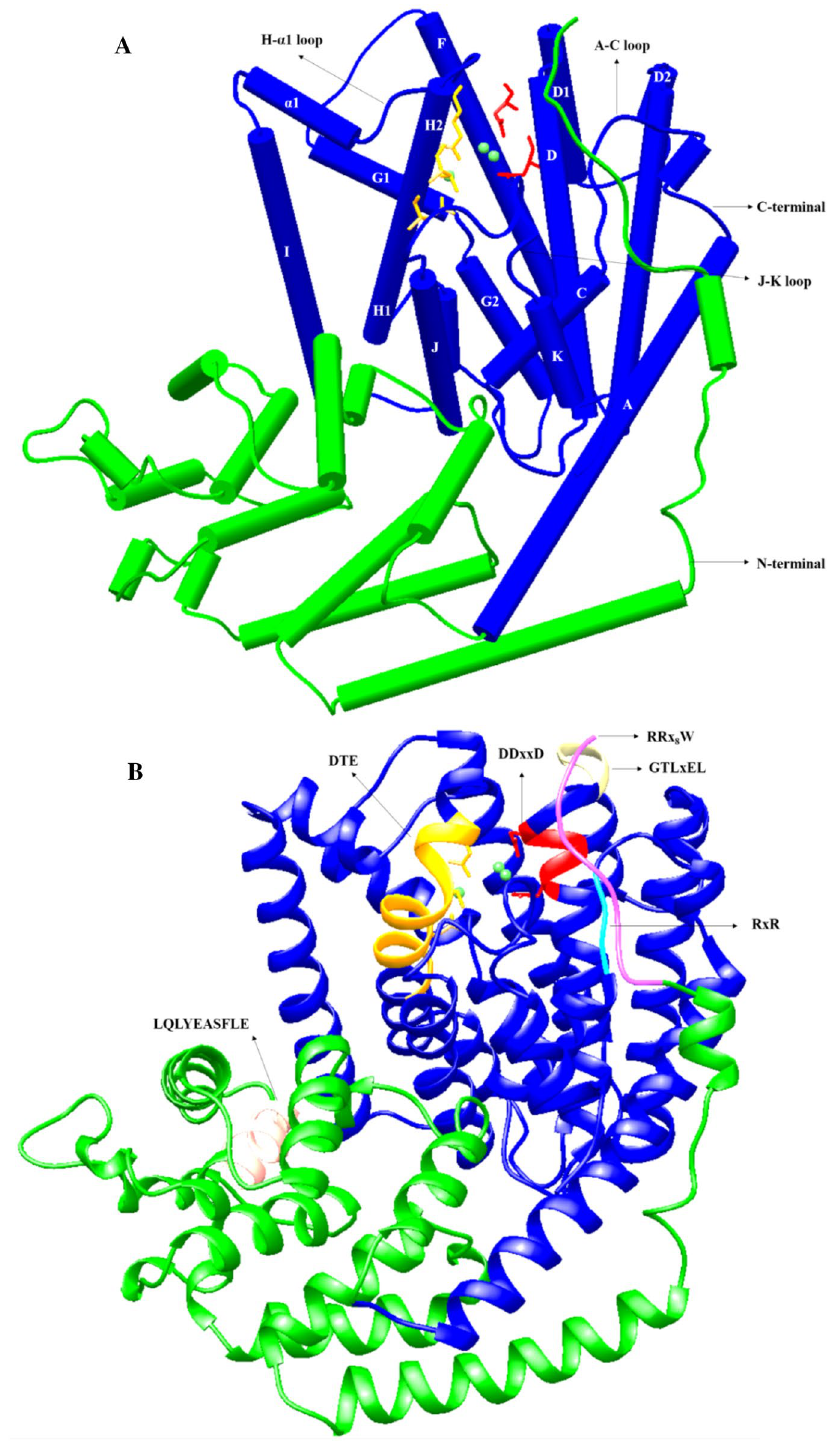
Figure 2. Protein homology modelling of Pam Tps1 using SWISS-MODEL server showed the structural domains and the active site of the enzyme. ( A ) model structure of Pam Tps1 made up of α-helices with N-terminal domain (green) and C-terminal domain (blue). ( B ) Ribbon view of Pam Tps1 model. The helical segment was designated according to Tarshis et al. 67 . All conserved motifs were labelled in the figure and Mg 2+ was illustrated as green